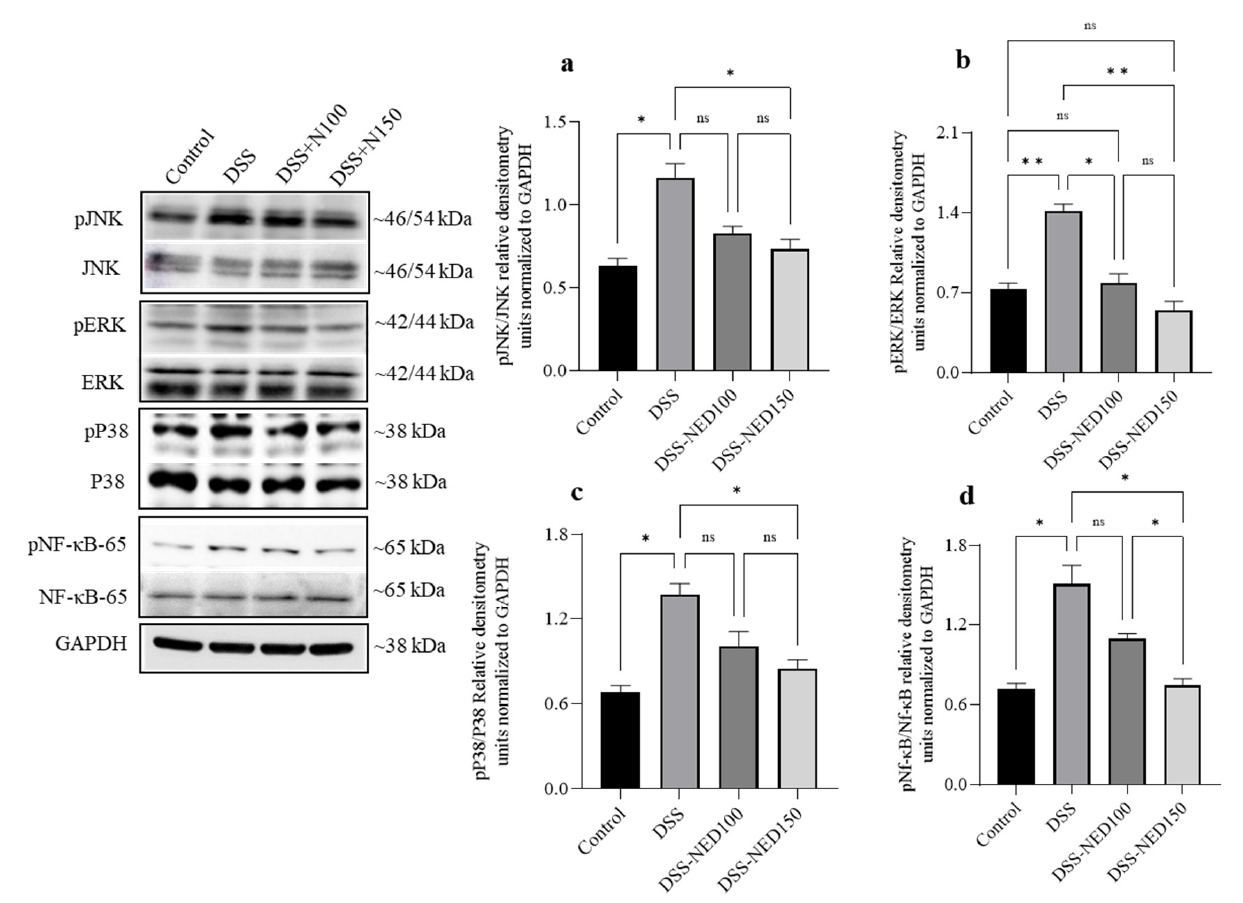
Figure 4. Effect of NED on the phosphorylation of MAP kinase and NF- κ B signaling pathways in DSS-induced colitis mice. Western blot experiments showed that NED treatment significantly inhibited the DSS-induced phosphorylation of JNK, ERK 1/2 , and p38 MAP kinases and NF- κ B in mice ( a – d ). Densitometry values are expressed as means ± SEM (n = 4). * p ≤ 0.05, ** p ≤ 0.01, and ns indicates not signi fi cant.